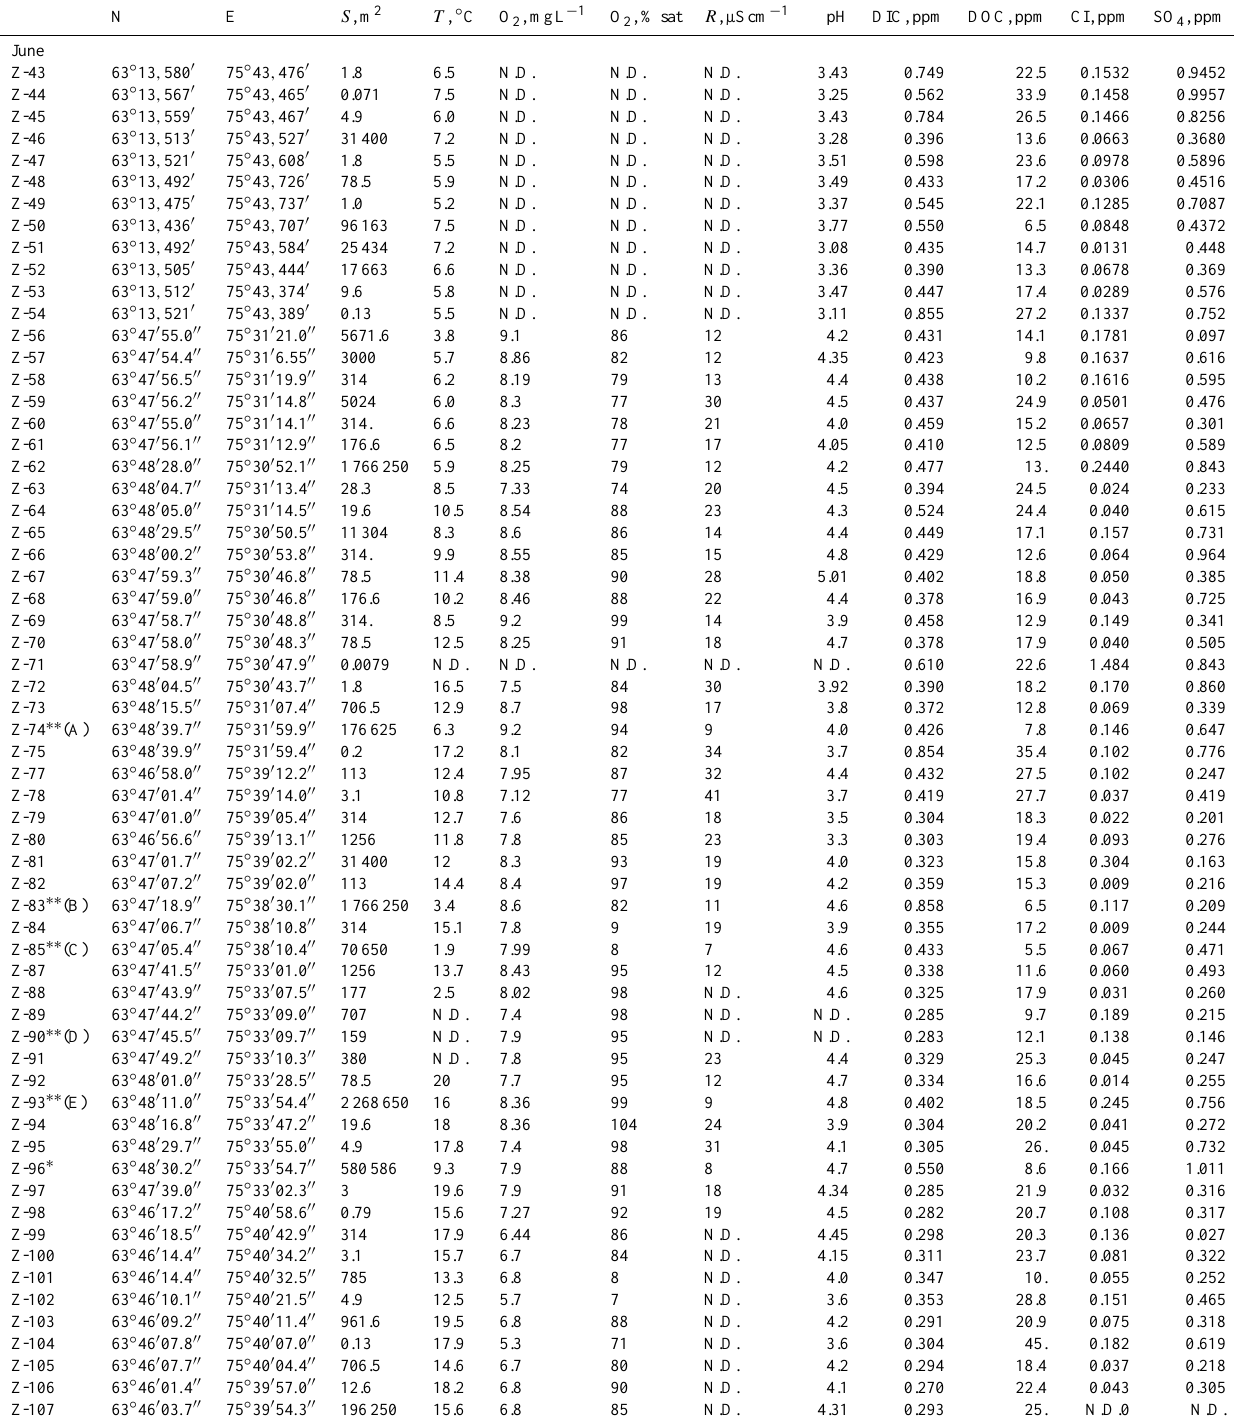
Table 1. Major hydrophysical and hydrochemical parameters of studied